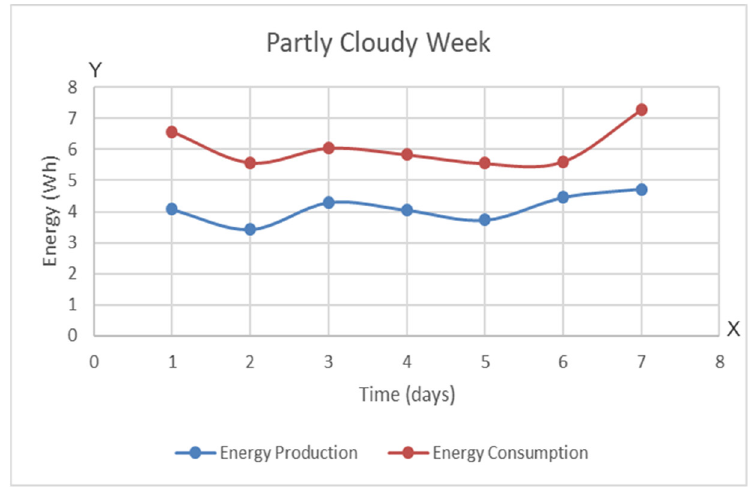
Figure 7. Modified Global Energy Production of the Solar Tracking Device using Reliability-Oriented Metrics for the Partly Cloudy Week.